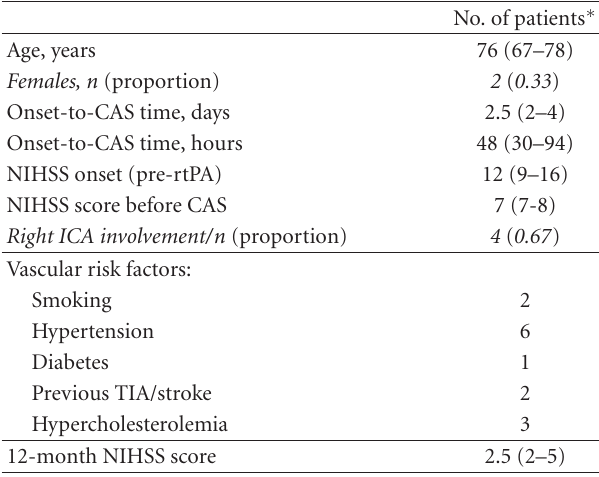
Table 1: Demographic and clinical data of six patients who had early carotid artery stenting after